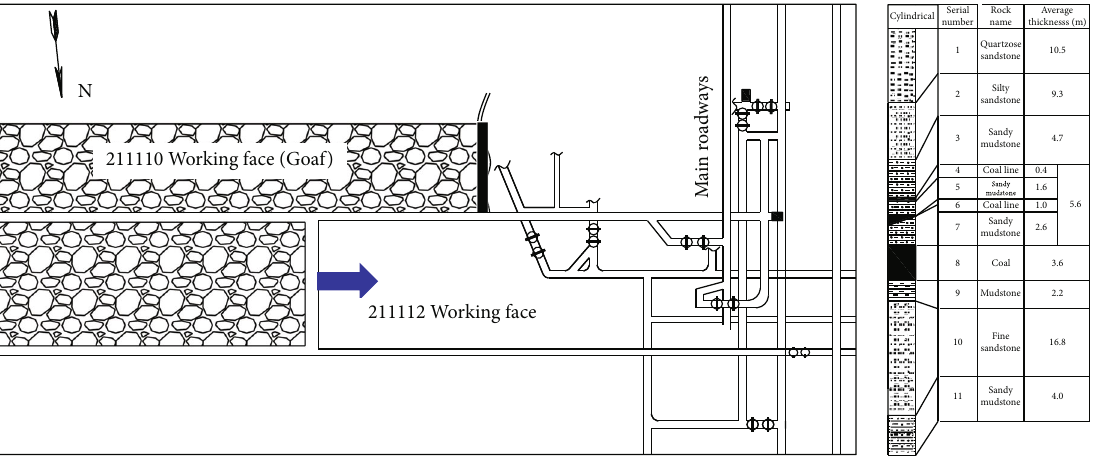
Figure 1: Working face layout.